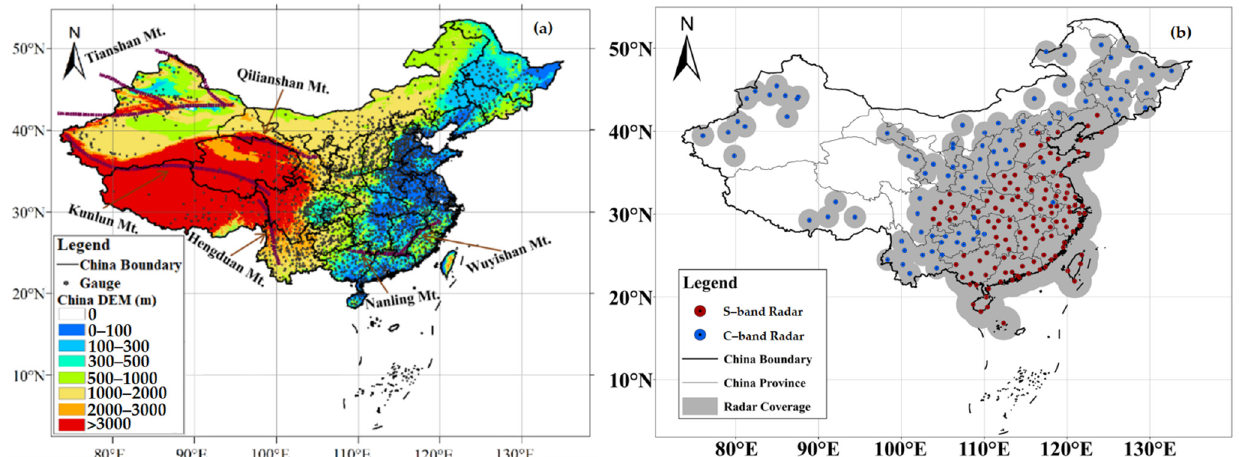
Figure 1. ( a ) Topographic features in China. Black dots show rain gauges. Mountain ranges are labeled and shown as dotted red lines; ( b ) CINRAD coverage map (without beam blockage) of 230 km for S-band and 150 km for C-band radar. White dots represent C-band radars, red dots show the S-band radars.